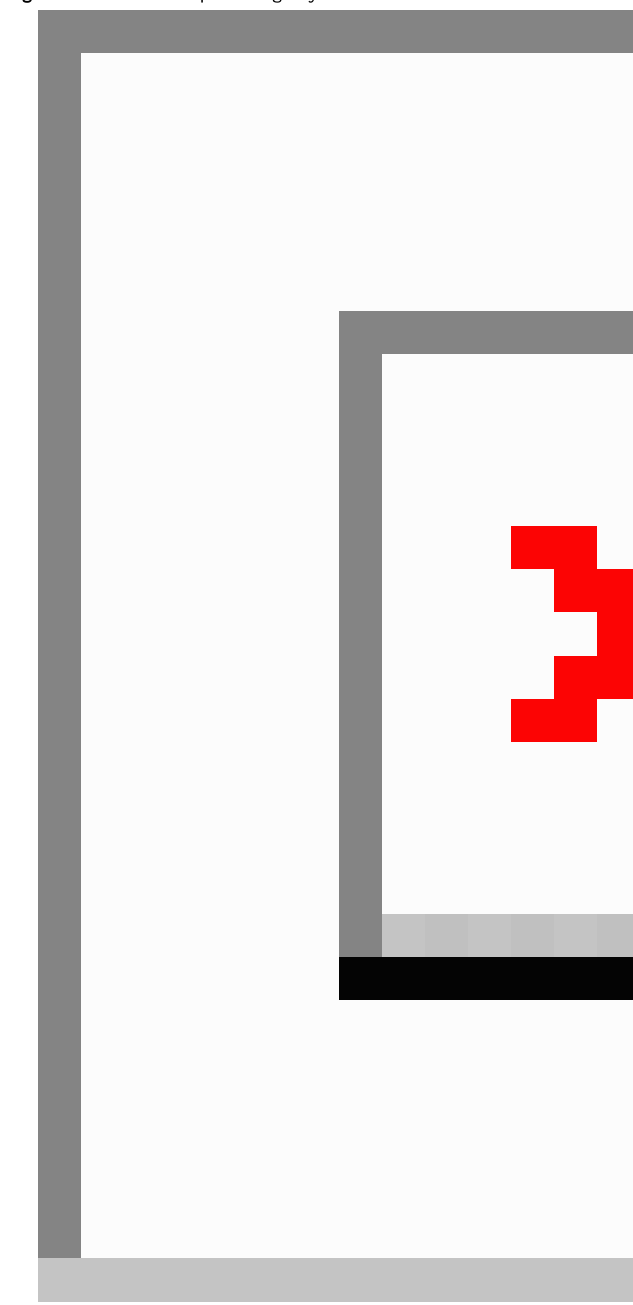
Figure 5. Evaluations percentage by result and